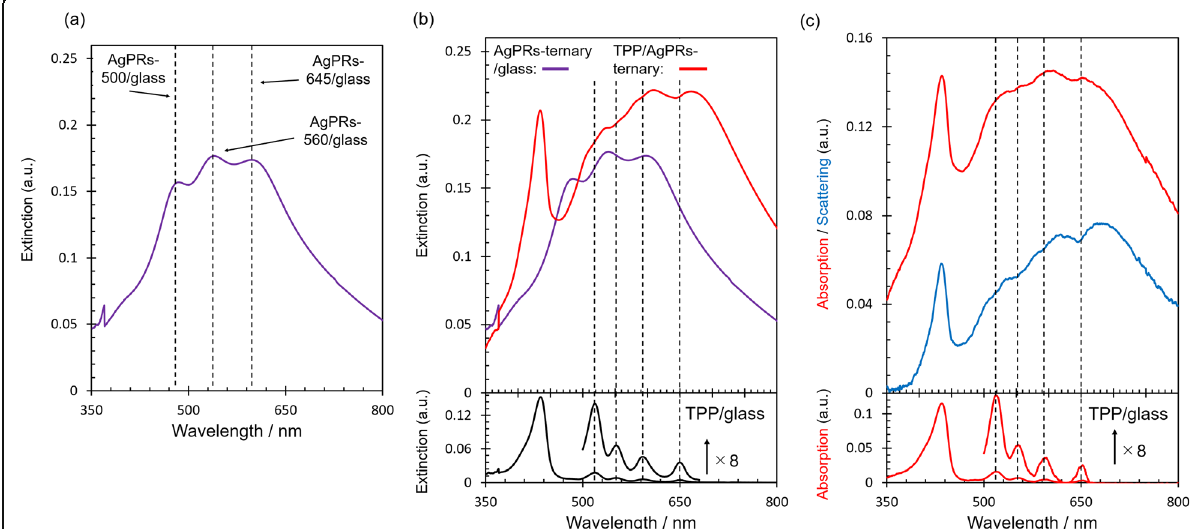
Fig. 5 a Extinction spectra of AgPRs-ternary/glass. Dashed lines represent LSP peaks of AgPRs-500/glass, AgPRs-560/glass, and AgPRs-645/glass. b Extinction spectra of AgPRs-ternary/glass, TPP/AgPRs-ternary, and TPP/glass. c Absorption and scattering spectra of TPP/AgPRs-ternary and TPP/glass